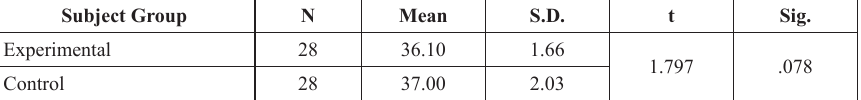
Table 3. The analysis of mean scores of mathematical conceptual understanding for the pre-test of two independent